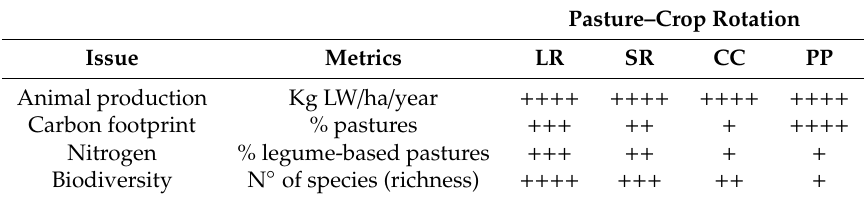
Table 1. Predicted environmental impact of the four systems in the ‘Palo a Pique’ long-term experiment, focused on carbon sequestration, nitrogen pollution and biodiversity (adapted from Kanter et al., 2016). Pasture–Crop Rotation Issue Metrics LR SR CC PP Animal production Kg LW / ha / year ++++ ++++ ++++ ++++ Carbon footprint % pastures +++ ++ + ++++ Nitrogen % legume-based pastures Biodiversity ++ +